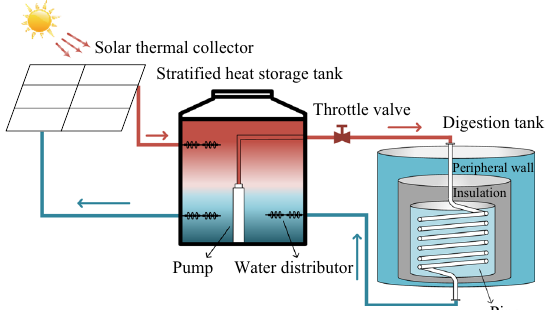
Fig. 1 Solar hot-water circulation for biogas digester